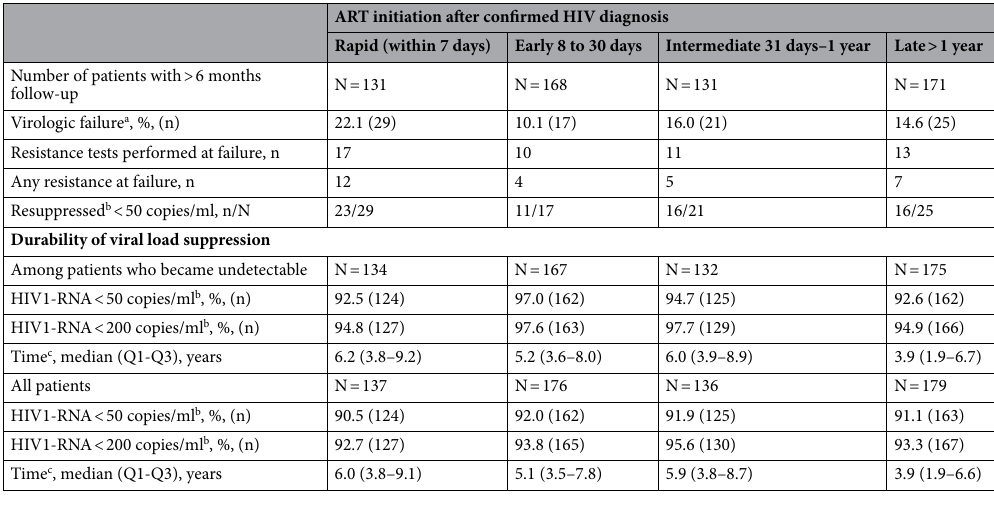
Table 3. Number of patients with viral load suppression, failure, resistance and durability of viral suppression according to timeliness of ART initiation, 2005–2014. ART antiretroviral therapy. a A single viral load measurement of HIV1-RNA > 1000 copies/ml at any time after 6 months of ART initiation (including patients who stopped ART). b Viral load at last measurement. c Time from antiretroviral therapy initiation to last HIV viral load